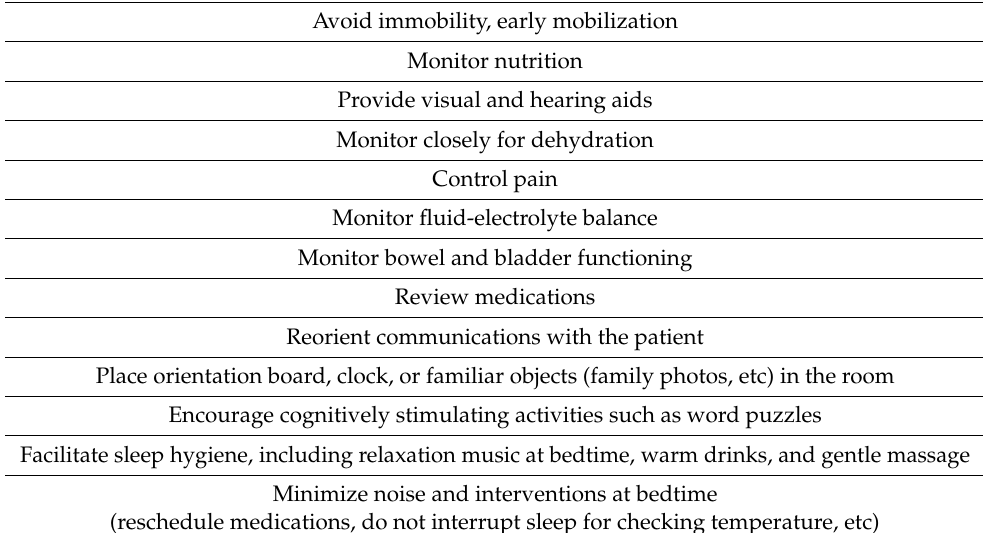
Table 2. Non-pharmacological interventions for delirium management. Adapted from Breitbart and Alici